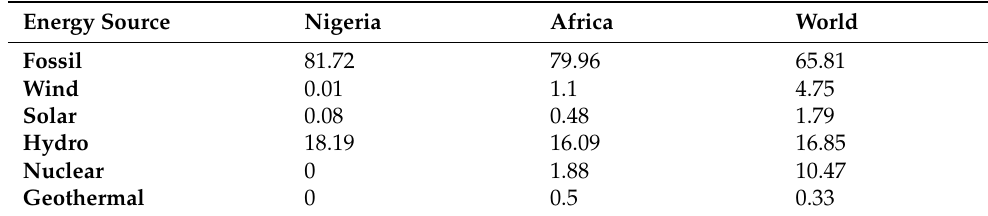
Table 9. Percent of electricity generation [115].